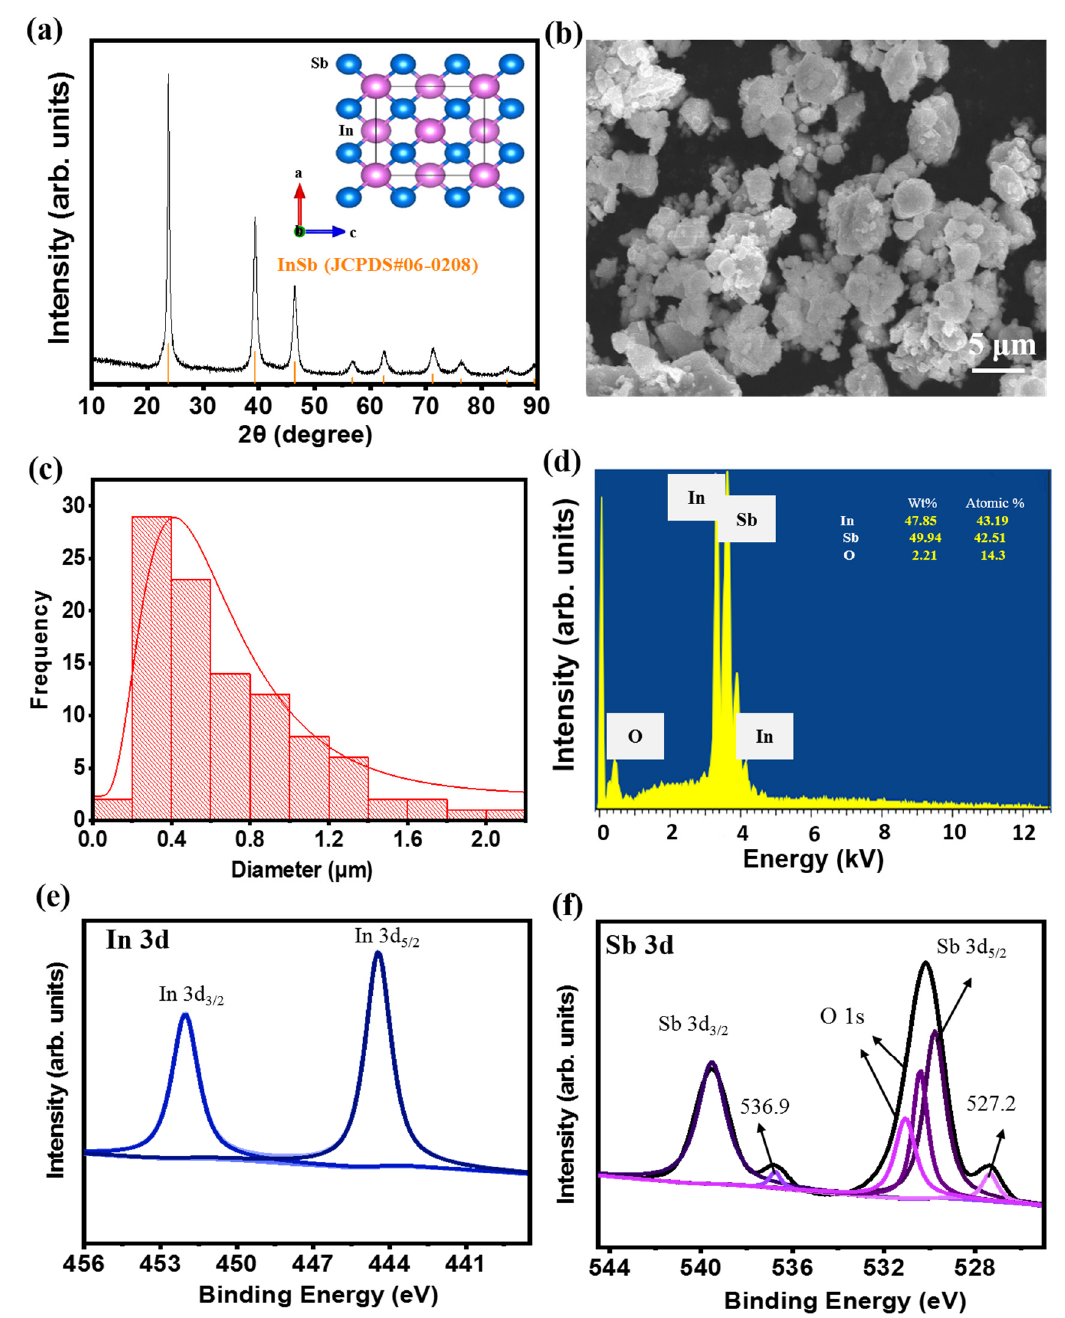
Figure 1. ( a ) XRD pattern (inset: crystalline structure), ( b ) SEM image, ( c ) particle size distribution, and ( d ) EDX spectrum of the as-synthesized InSb powder. XPS profiles of ( e ) In 3d, and ( f ) Sb 3d for the InSb powder. The half-cell performance of InSb was measured using two different binders (PAA and PVDF) to investigate its electrochemical behavior (Figure 2). The GCD voltage pro- files of InSb_PAA and InSb_PVDF are shown in Figures 2a and S2, respectively. The initial charge/discharge capacities of InSb_PAA and InSb_PVDF were 790/635 and 770/643 mAh g − 1 , respectively, corresponding to initial coulombic efficiencies (ICEs) of 80.9% and 83.5%. The irreversible capacity losses in the first cycle are associated with the formation of an SEI layer for both electrodes. Although the specific capacities of InSb were not signifi- cantly different for PAA and PVDF in the first cycle, a significant capacity reduction was observed for InSb_PVDF during the initial 10 cycles at both low (Figure 2b) and high